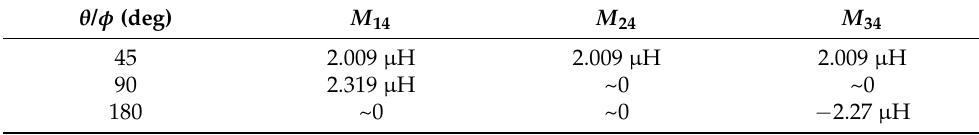
Table 3. Mutual coupling values of this